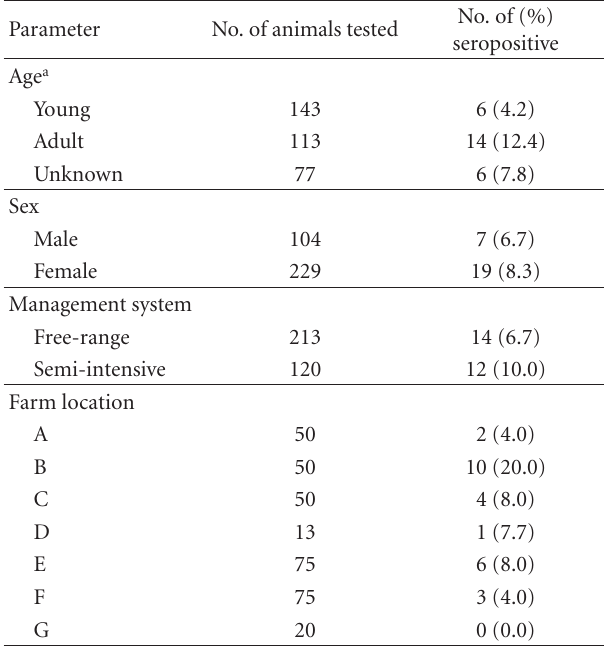
Table 1: Frequency of toxoplasmosis in water bu ff alo by risk